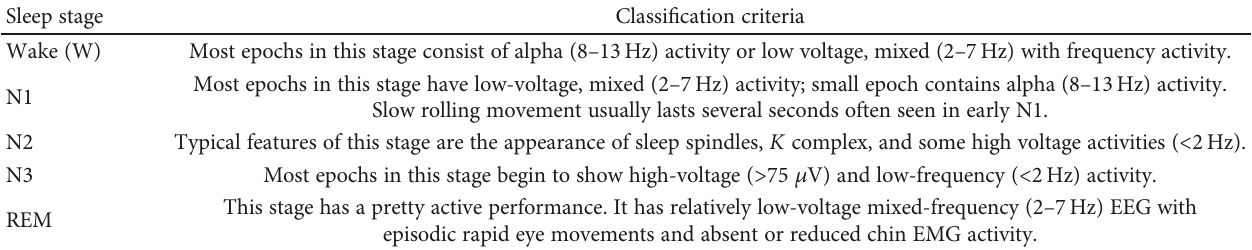
Table 1: The AASM staging criteria. Classi fi cation